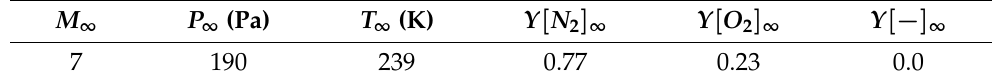
Table 9. X-43a free-stream conditions.